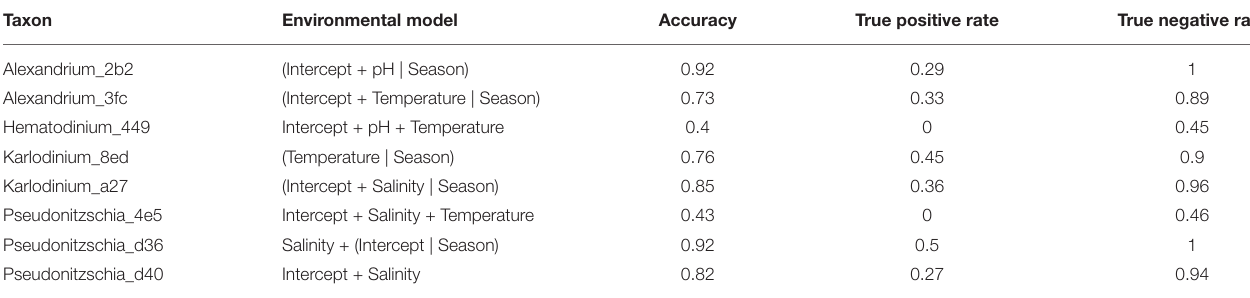
TABLE 2 | Best-fit models of environmental covariates for eight focal algal lineages.